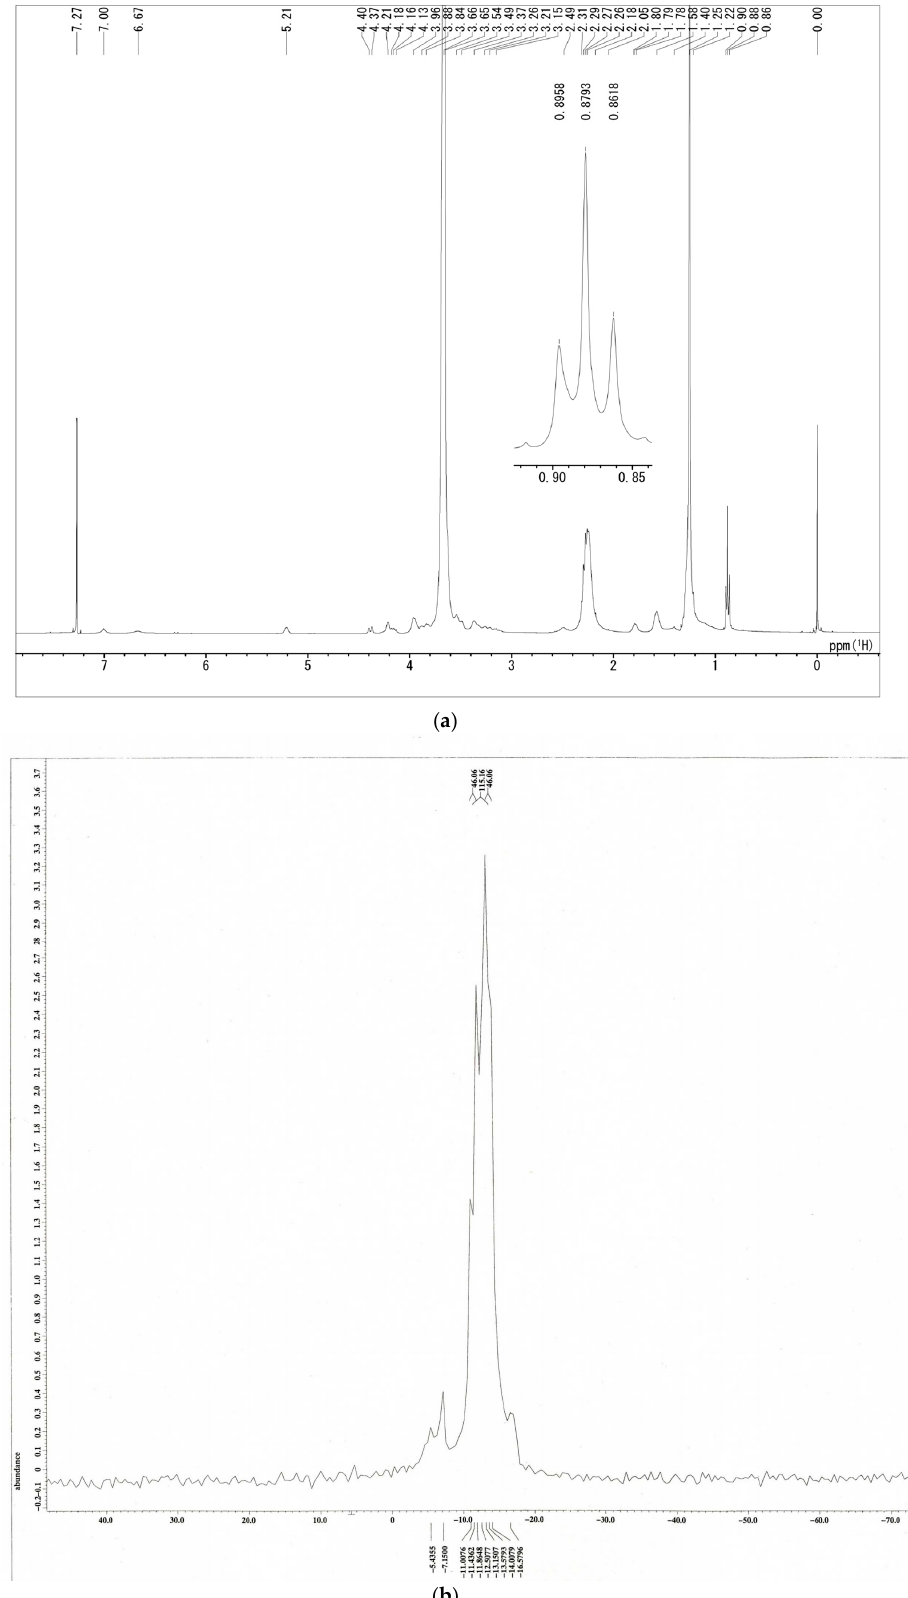
Figure 3. NMR spectra of PBL: ( a ) 1 H-NMR spectra; ( b ) 10 B-NMR spectra.